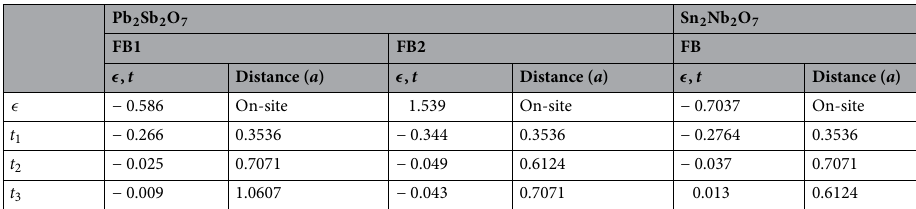
Table 1. Tight-binding parameters for pyrochlore Pb 2 Sb 2 O 7 and Sn 2 Nb 2 O 7 . (a) Four-orbital MLWF model centered with the Pb site for FB1 of Pb 2 Sb 2 O 7 , (b) four-orbital MLWF model centered with the Sb site for FB2 of Pb 2 Sb 2 O 7 , and (c) four-orbital MLWF model centered with the Sn site for the flat band of Sn 2 Nb 2 O 7 .